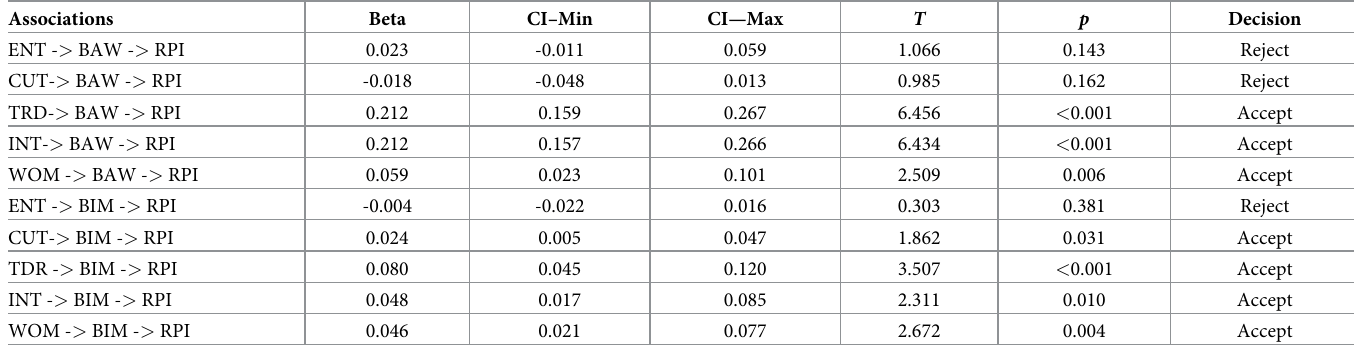
Table 7. Indirect